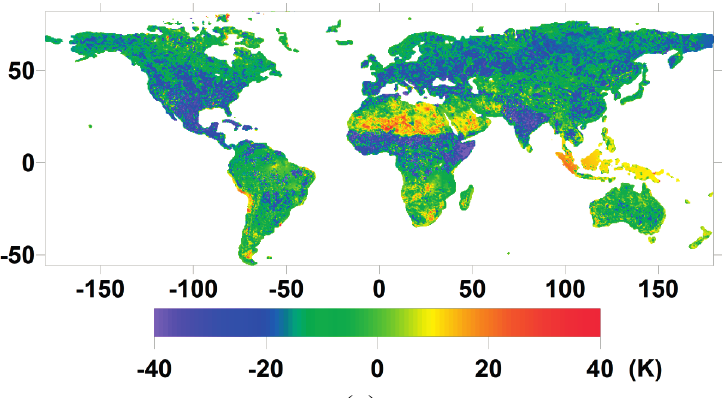
Figure 5. Example global distributions of the empirical ( a ) intercept and ( b ) slope values that define the linear relationship between AMSR2 T and the AMSR-E baseline (independent variable) for ascending H-Polarized observations at 23